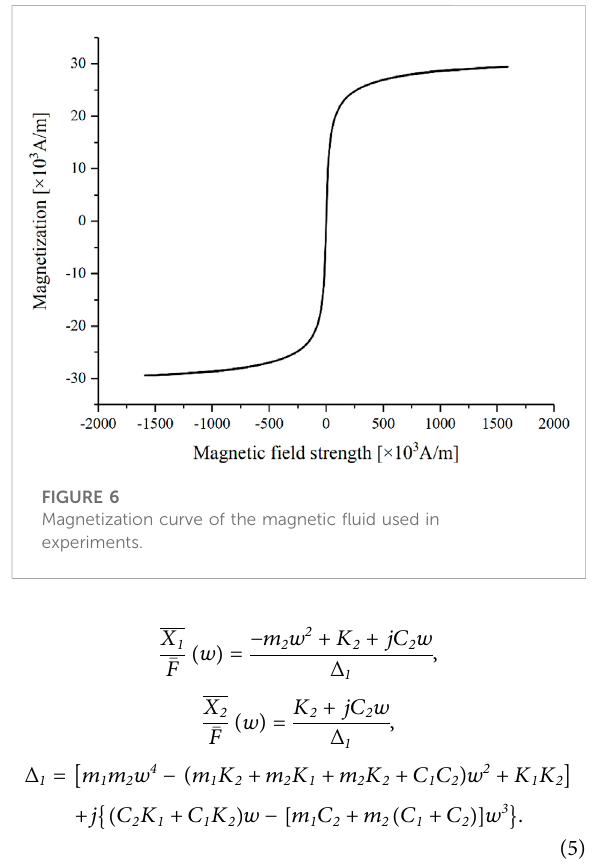
FIGURE 6 Magnetization curve of the magnetic fl uid used in experiments.